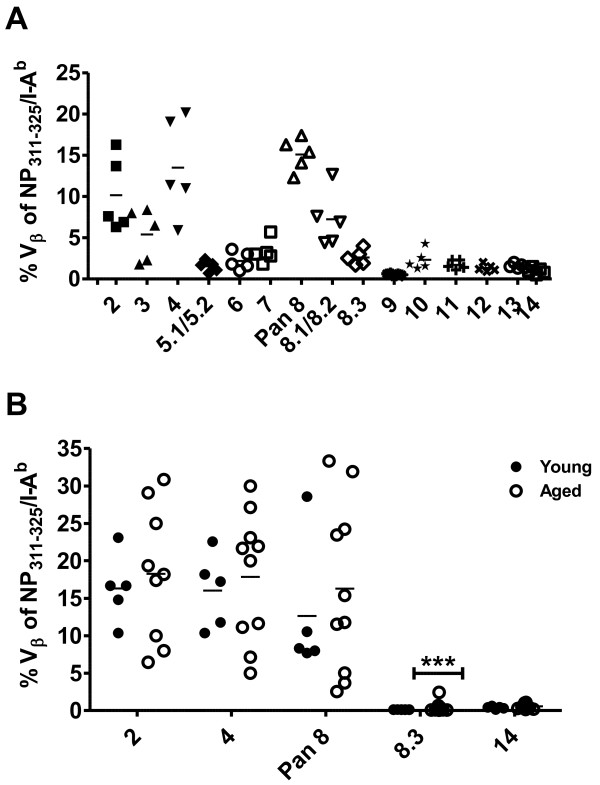
The T cell receptor Vβ repertoire of influenza NP-specific young and aged CD4 T cells. Ten days after i.n. infection with 3,000 EID50 ×-31 influenza virus, the repertoire of NP311–325/IAb-specific CD4 T cells in the lungs of mice was assessed by T cell receptor Vβ staining of tetramer-positive CD4 T cells. Panel A shows repertoire analysis of NP311–325/IAb-specific CD4 T cells from the lungs of individual influenza virus-infected young mice (n = 5) using the full panel of anti-Vβ antibodies. Pan 8 signifies Vβ8.1, 8.2 and 8.3. Values for each Vβ are represented by a different symbol. Panel B shows selected T cell receptor Vβ repertoire analysis of NP311–325/IAb-specific CD4 T cells from the lungs of individual young (closed circles, n = 5) and aged (open circles, n = 10) mice 12 days post infection. Variances were compared by F test (***p < 0.0005). Group means are indicated by bars.